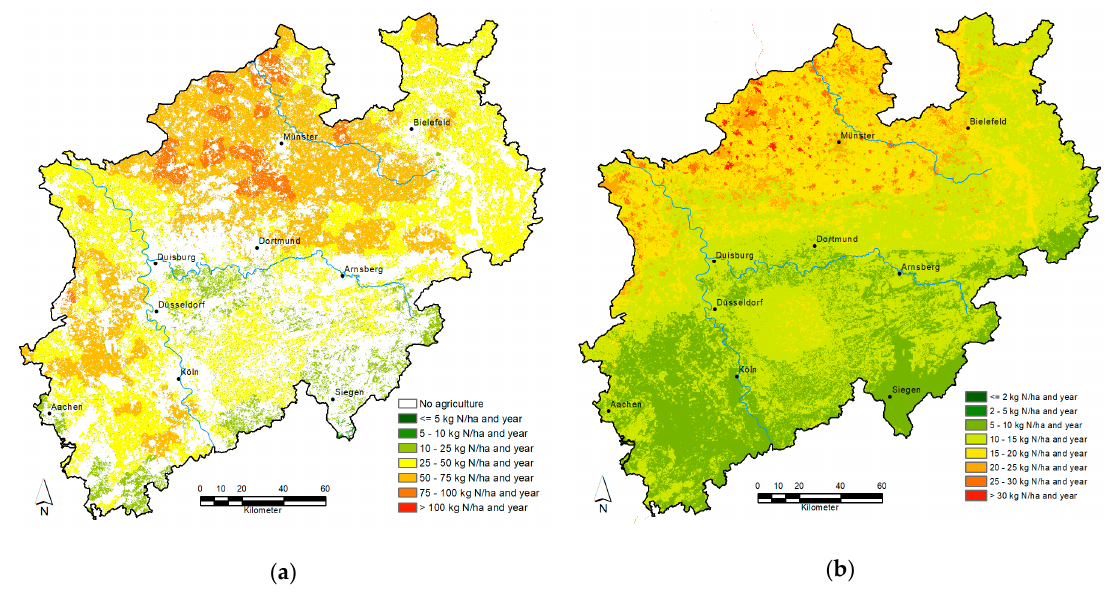
Figure 3. ( a ) Agricultural N balance surplus and ( b ) atmospheric NHx deposition.